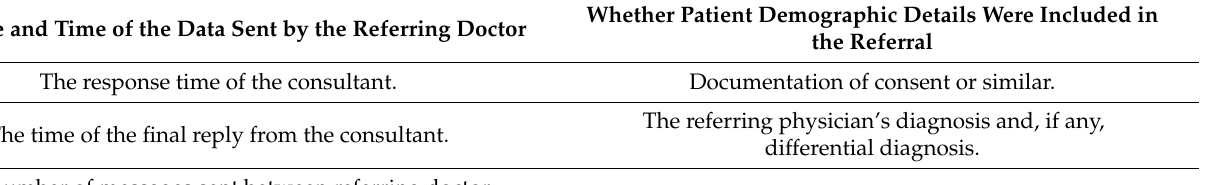
Table 1. Data extracted from WhatsApp chat referrals provided by